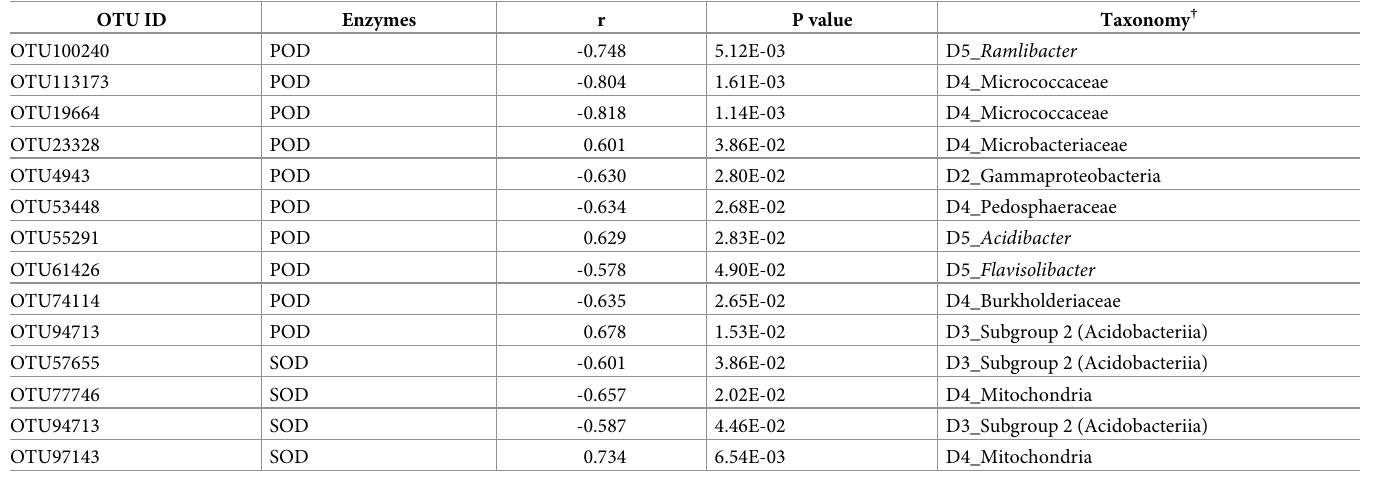
Table 2. Spearman correlations between dominant OTUs and POD,